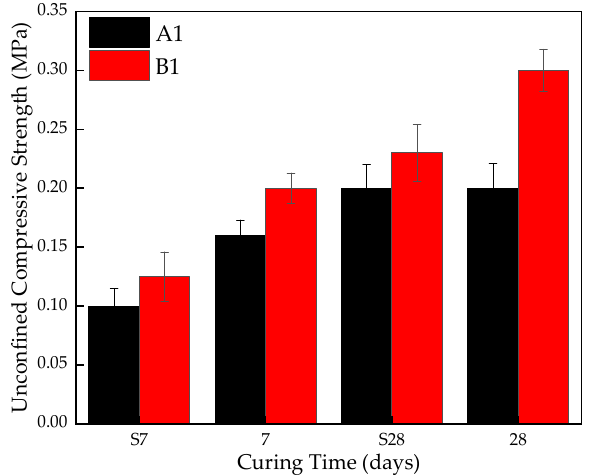
Figure 7. Effect of TG on UCS of stabilized silt.